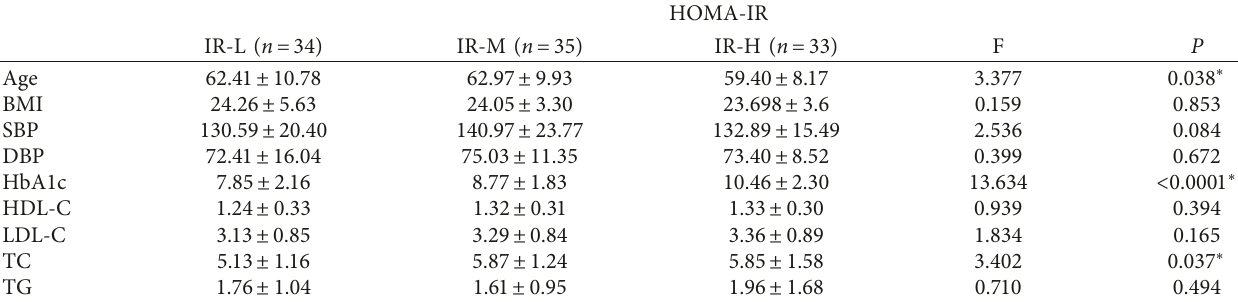
Table 2: Comparison of general clinical information in three HOMA-IR